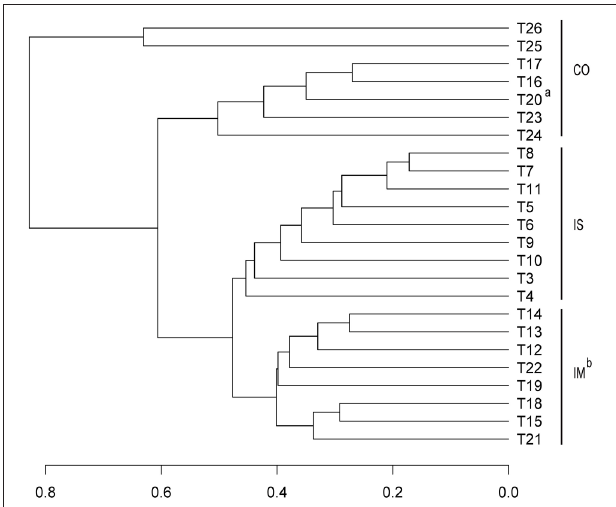
FIGURE 2 | Bray-Curtis dissimilarity based dendrogram at the OTU level illustrating groups for surface sea water. CO, Coastal stations; IM, open sea stations from Indian Monsoon Gyre Province; and IS, open sea stations from Indian Subtropical Gyre Province. a T20 located in southwest of South China Sea showed a similar microbial community with coastal water group; b Stations located in the semi-close marginal seas were clustered together with IM stations.